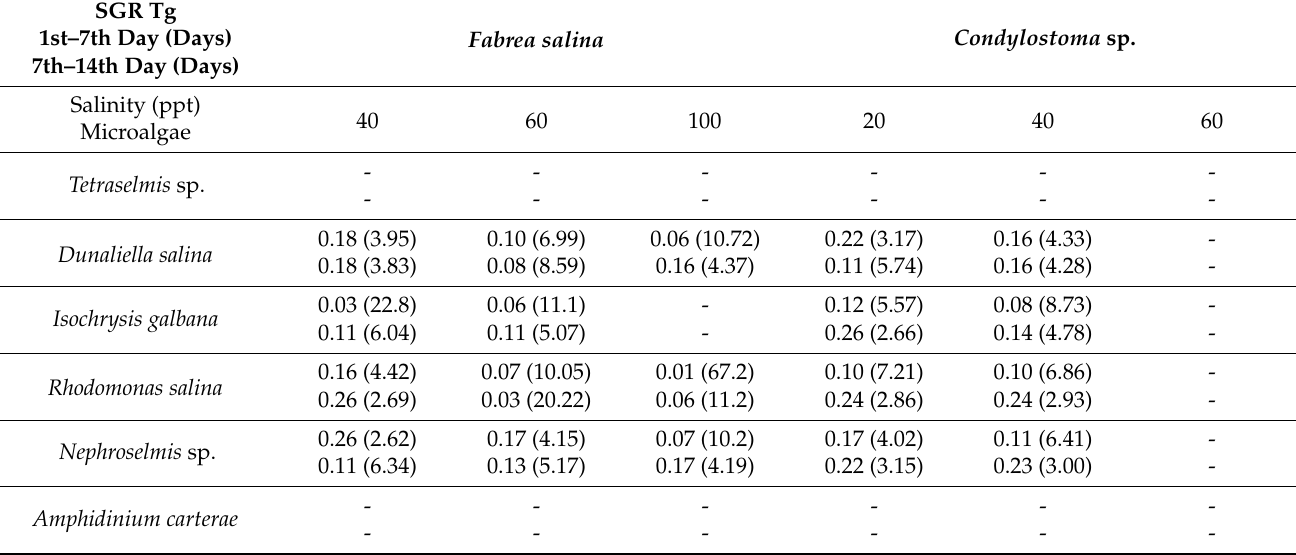
Table 1. Specific growth rate (SGR) of F. salina and Condylostoma sp. fed different microalgae at different